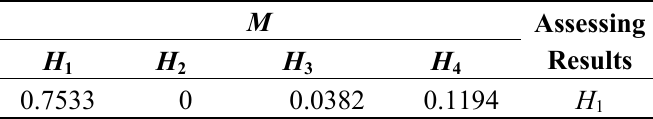
Table 8. Results of condition